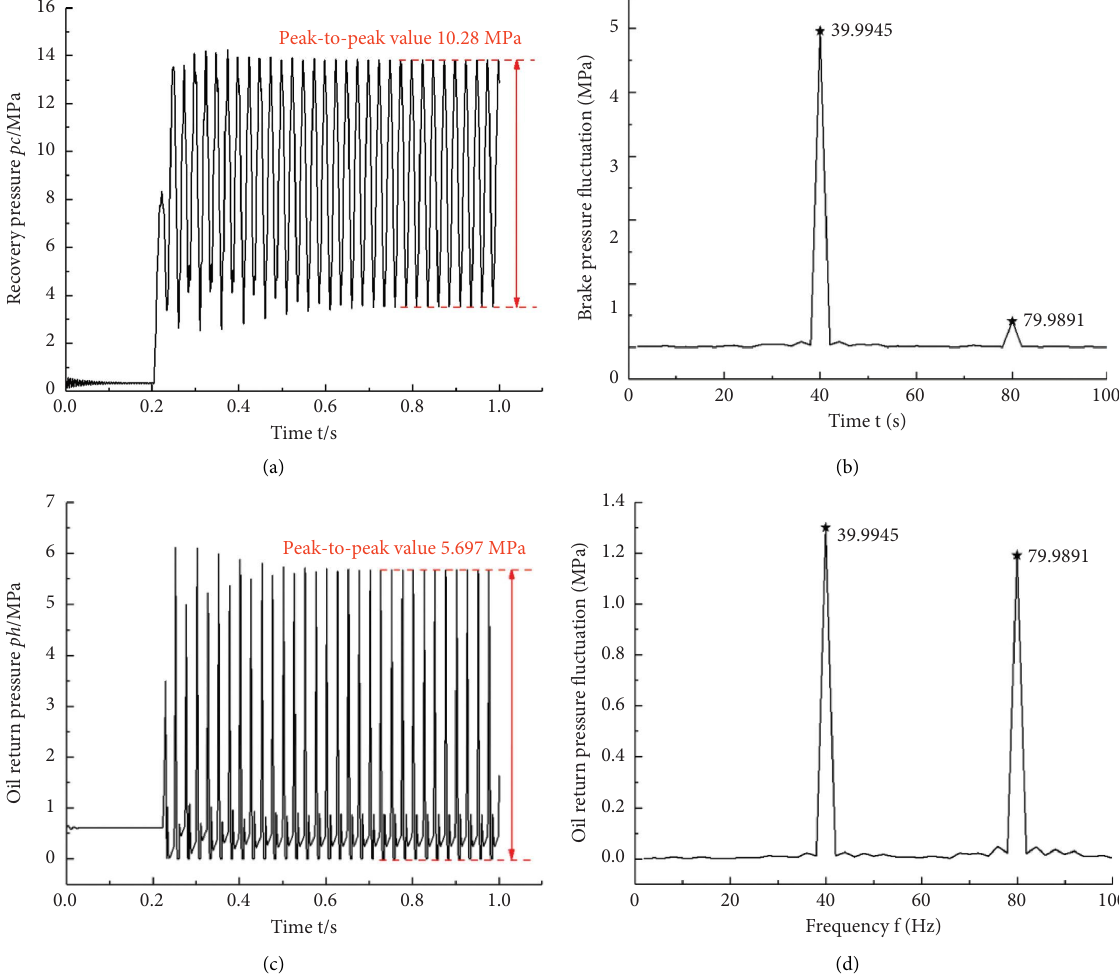
b . (b) Brake pressure p b FFTspectrum. (c)